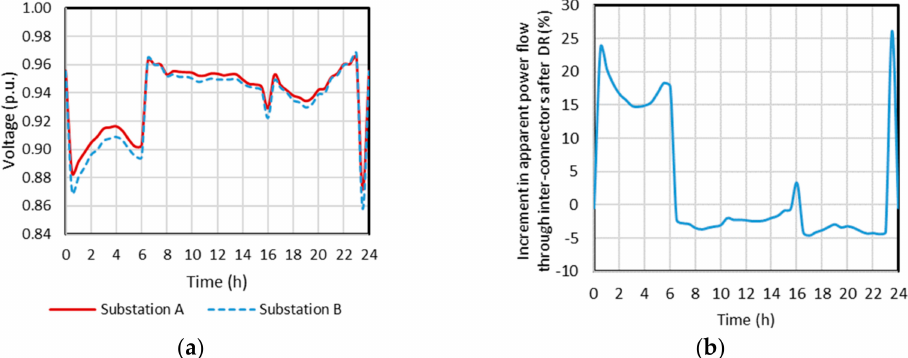
Figure 6. ( a ) Secondary voltage at transformers of both substations and ( b ) increment in apparent power flow through inter-connectors after the implementation of DR for scenario